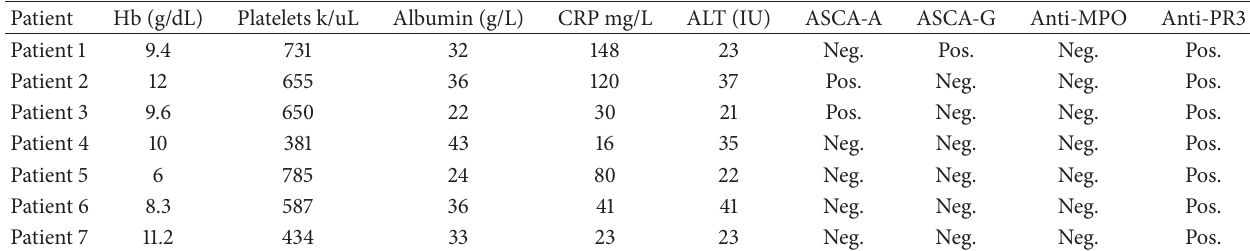
Table 2: Laboratory investigations of IBD patients with positive c-ANCA.